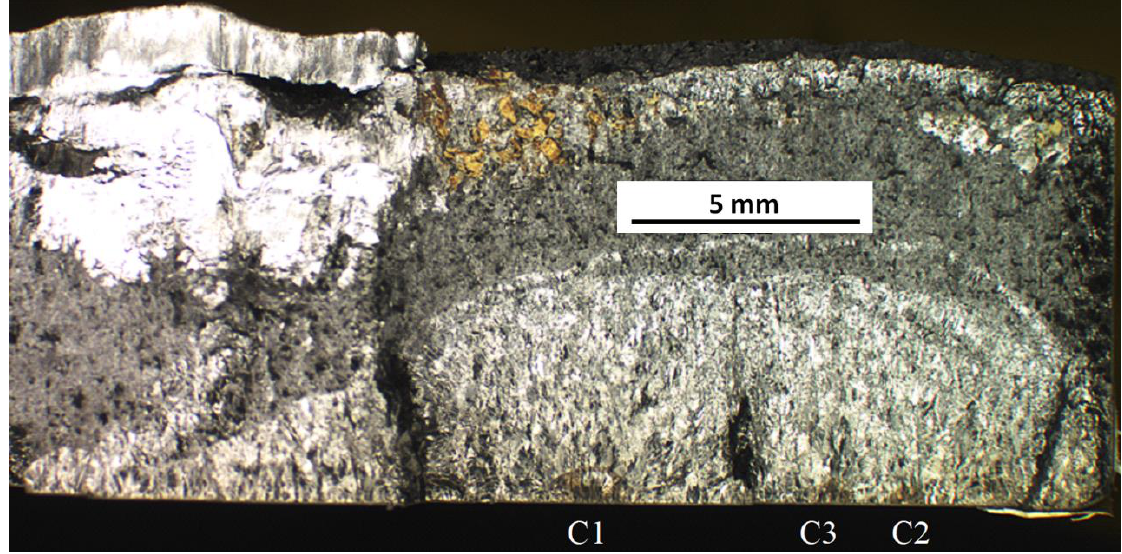
Figure 4. Optical colour fractograph of a relatively large crack in the AA7050-T7451 Y470 bulkhead flange. This fractograph shows three fatigue nucleation locations, labelled C1, C2 and C3, from [14].